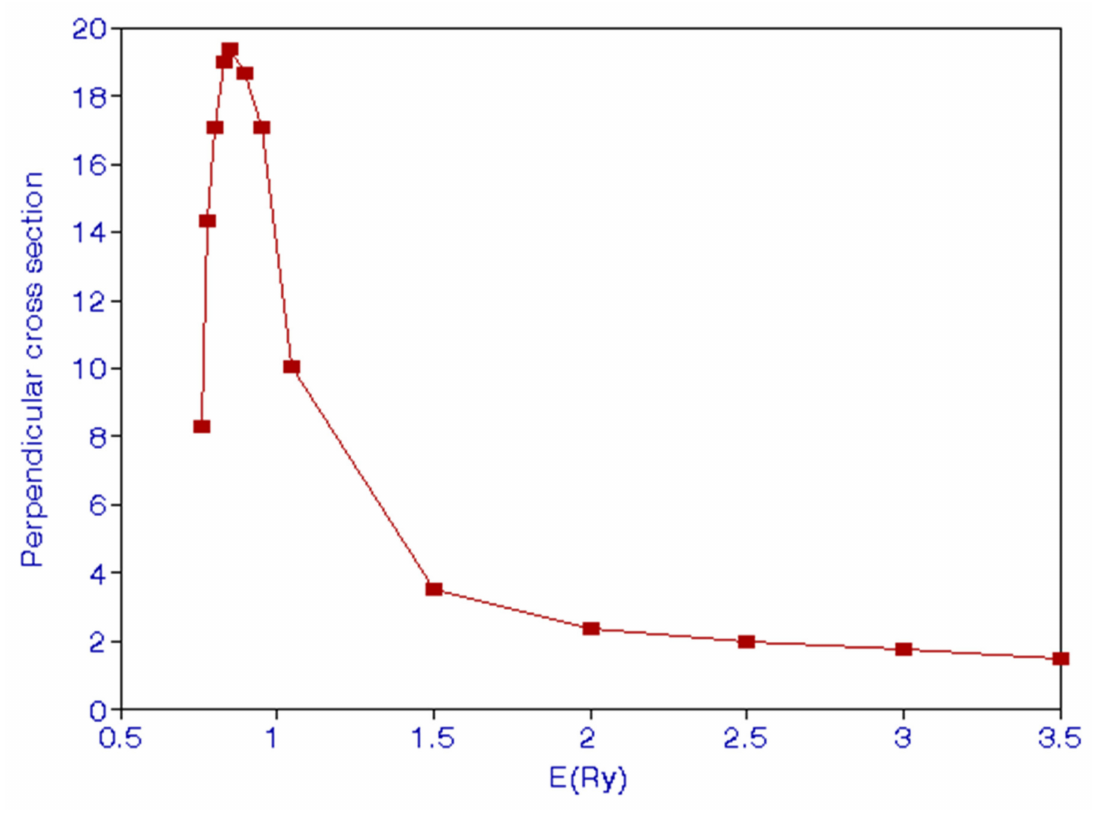
Figure 4. (Color online) Behavior of the perpendicular cross section, σ ⊥ , with the incident energy E